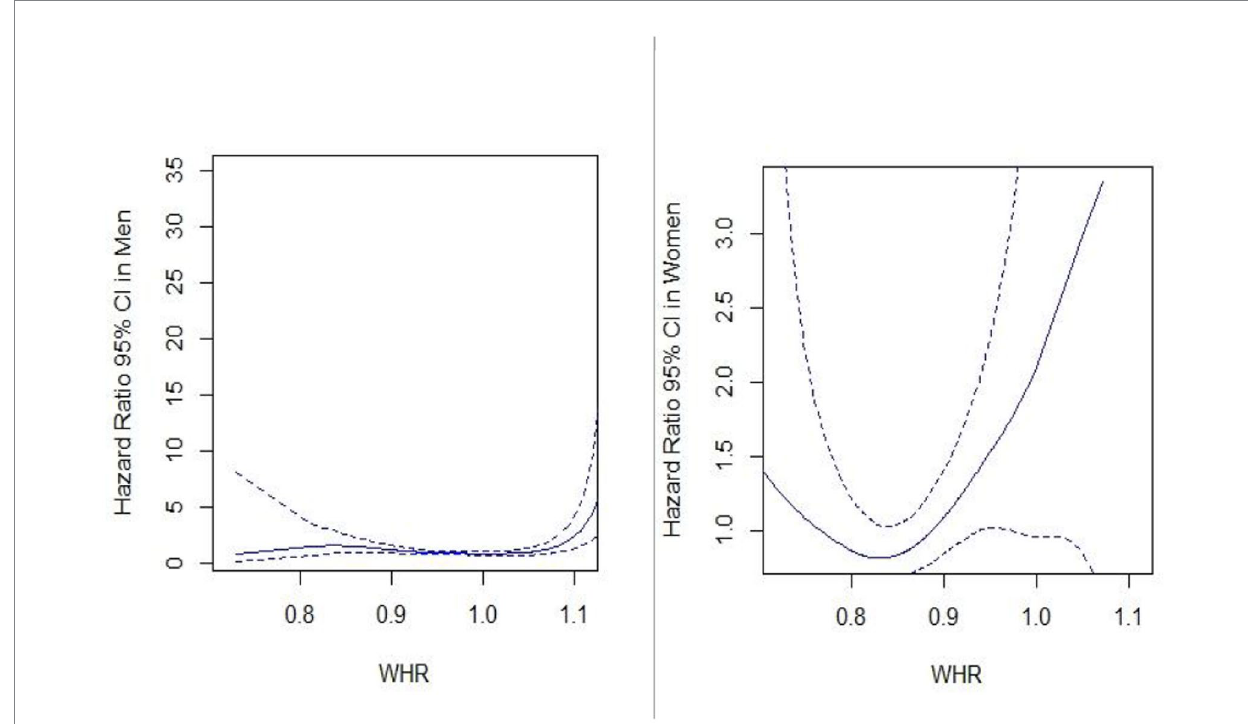
FIGURE 6 Association between waist-hip ratio (WHR) with all-cause mortality in men and women. Hazard ratios of all-cause mortality are calculated by the spline Cox proportional hazard model. Solid lines and dash lines, respectively, represent the hazard ratios and their 95% confidence intervals after adjusting for MM, age, education, family status, smoking habit, alcohol use, and physical activity.